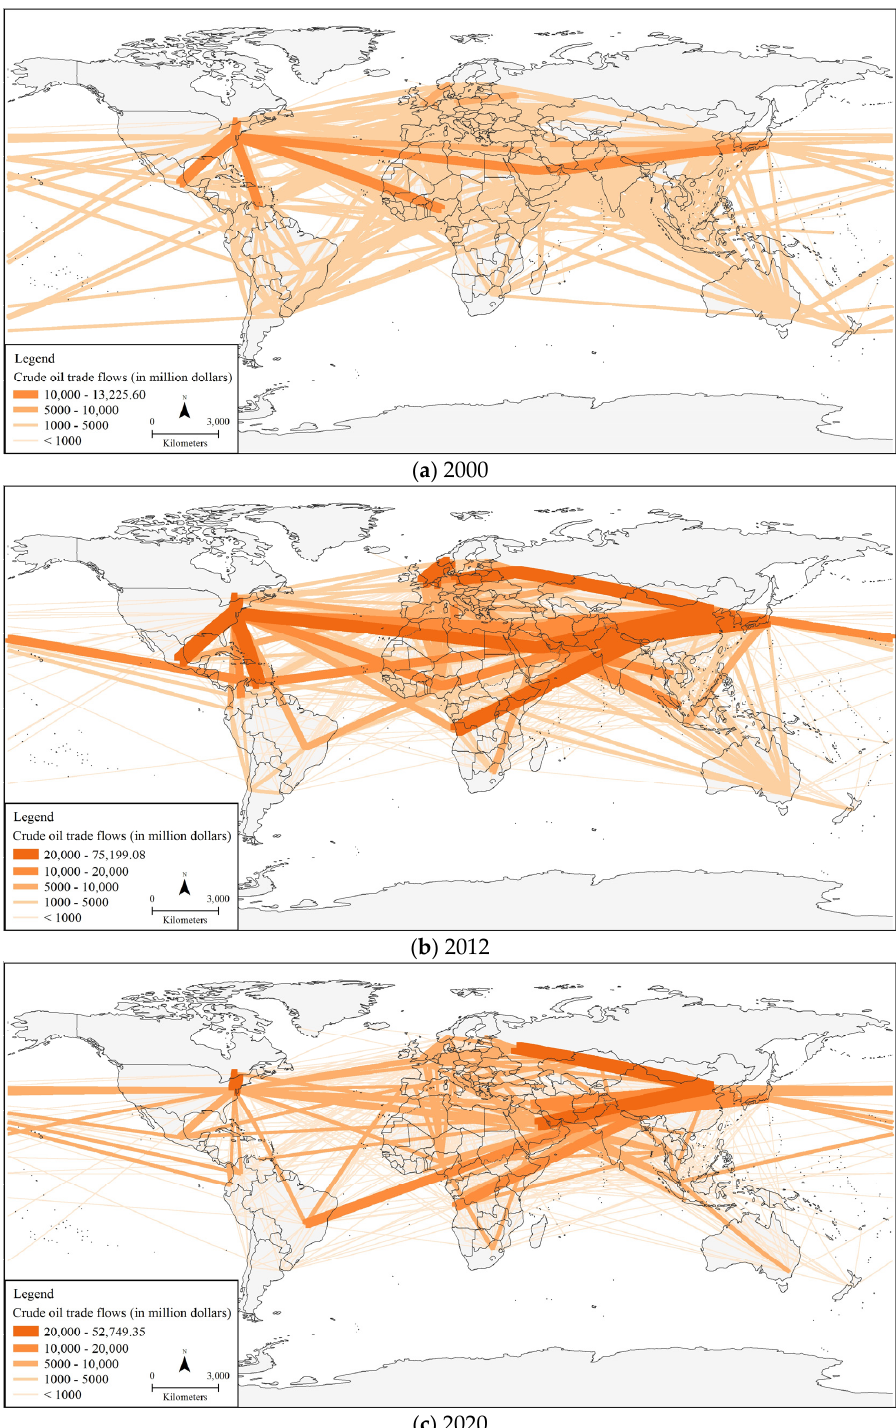
Figure 2. Evolution of the global crude oil trade patterns. The world crude oil trade shows two phases: the growth period and the adjustment period. From 2000 to 2012, international crude oil trade achieved substantial growth, and